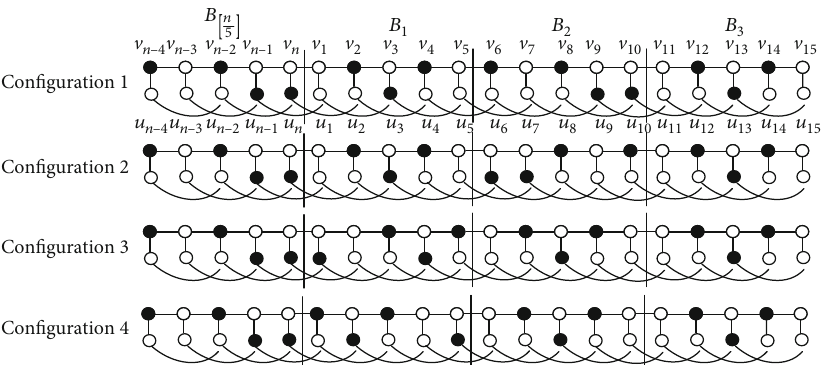
, B 1 2 with 7 guards.